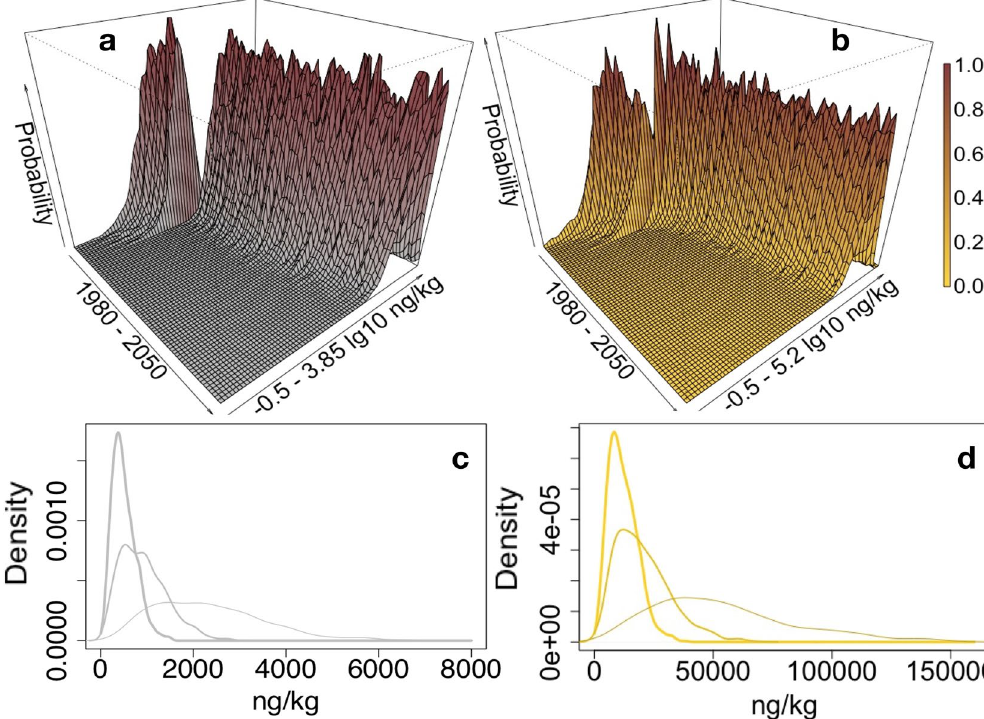
Figure 5. Temporal dynamics of CeO 2 -ENM PEC (most probable range) for agricultural soils (left side, scenario of immediate ENM degradation after one year ( a and c ); right side ( b and d ), persistent scenario of no ENM degradation or elimination at all after being released into soils). The density curves refer in each scenario ( c out of a , and d out of b ) to the results for 2017, 2030, and 2050 (from